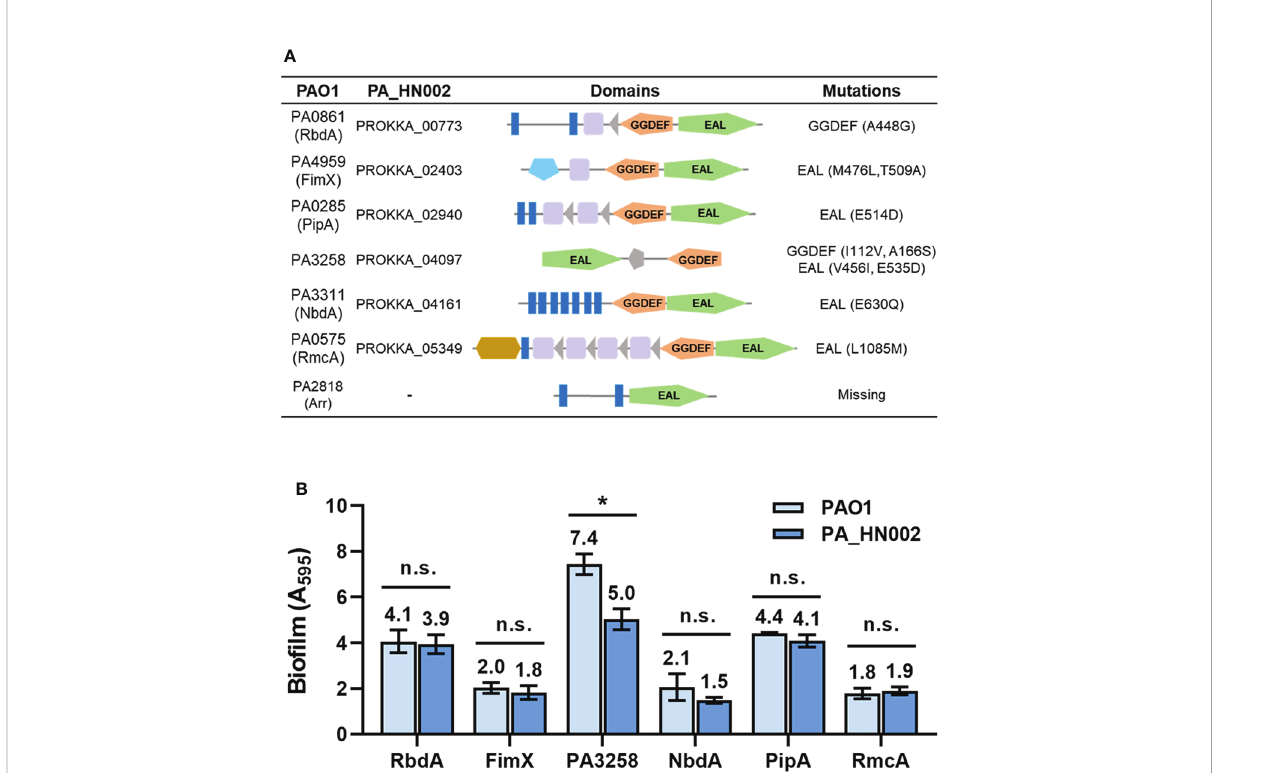
FIGURE 5 Mutations in the c-di-GMP metabolizing enzymes from PA_HN002 relative to those from PAO1. (A) A s ummary of mutations within c-di-GMP metabolizing enzymes PA0861 (RbdA), PA4959 (FimX), PA0285 (PipA), PA3258, PA3311 (NbdA), PA0575 (RmcA) and PA2818 (Arr) in PA_HN002 relative to the sequences in PAO1. (B) Bio fi lm formation of the PA_HN002 strain with overexpression of the PA0861 (RbdA), PA4959 (FimX), PA0285 (PipA), PA3258, PA3311 (NbdA), PA0575 (RmcA) encoding genes from PAO1 and PA_HN002, respectively. n.s., not signi fi cant, * P <0.05 based on Student ’ s t